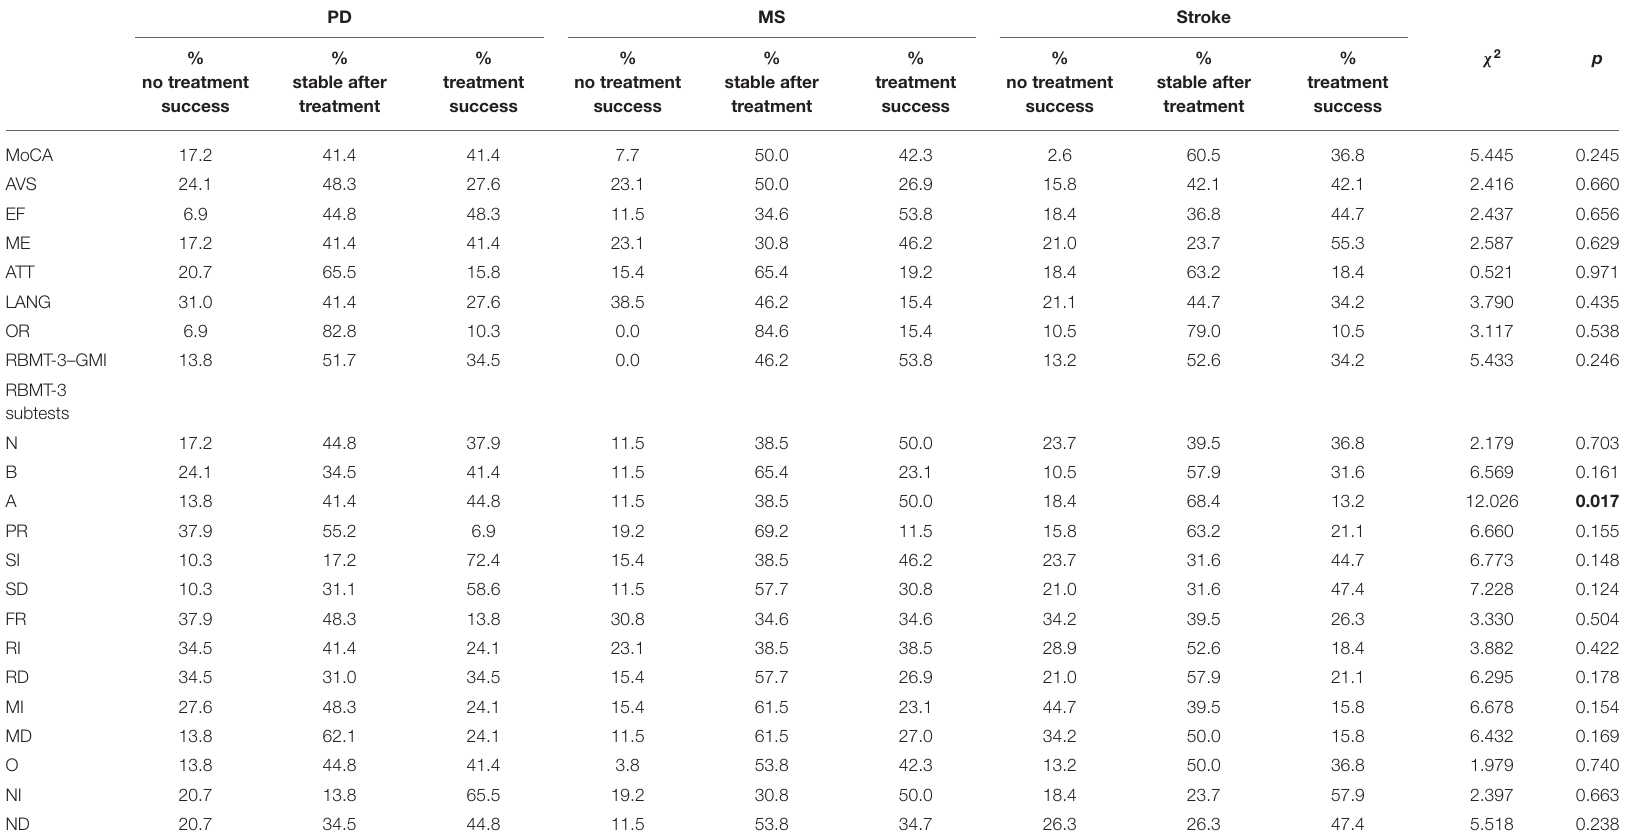
TABLE 4 | Changes within each pathology between T0 and T1 and comparison results of treatment effect vs. no effect cases. PD MS